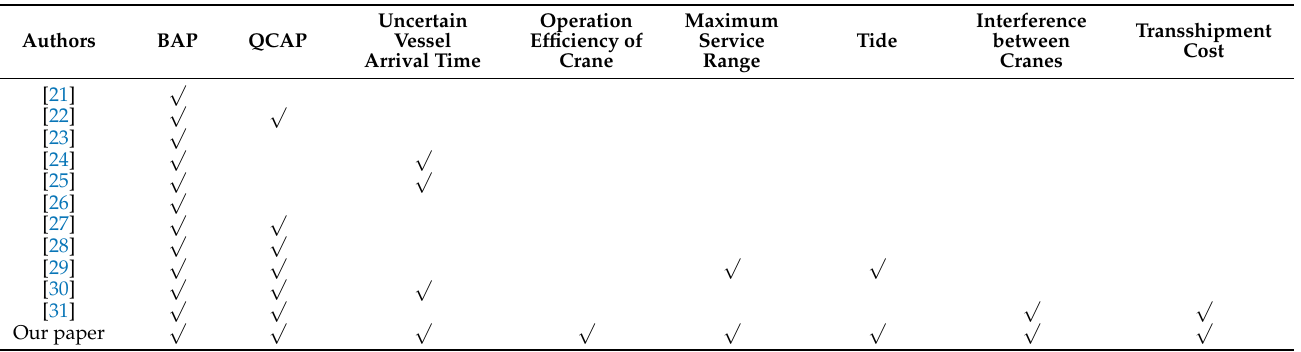
Table 1. Comparison of frontier operations scheduling studies in multi-terminal